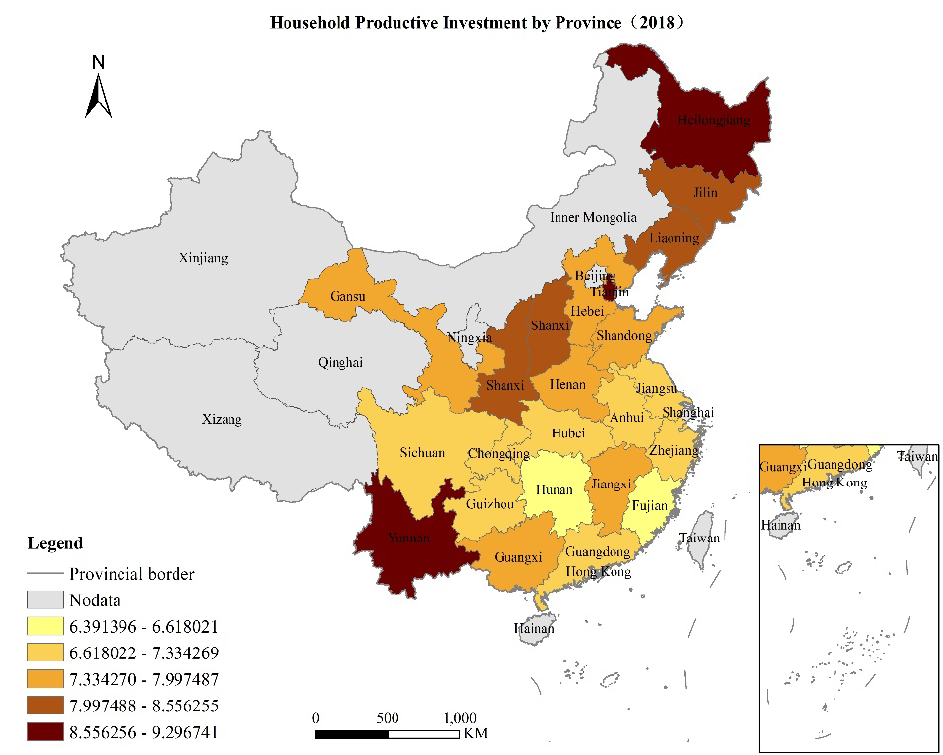
Figure 4. Household productive investment by province (2018).